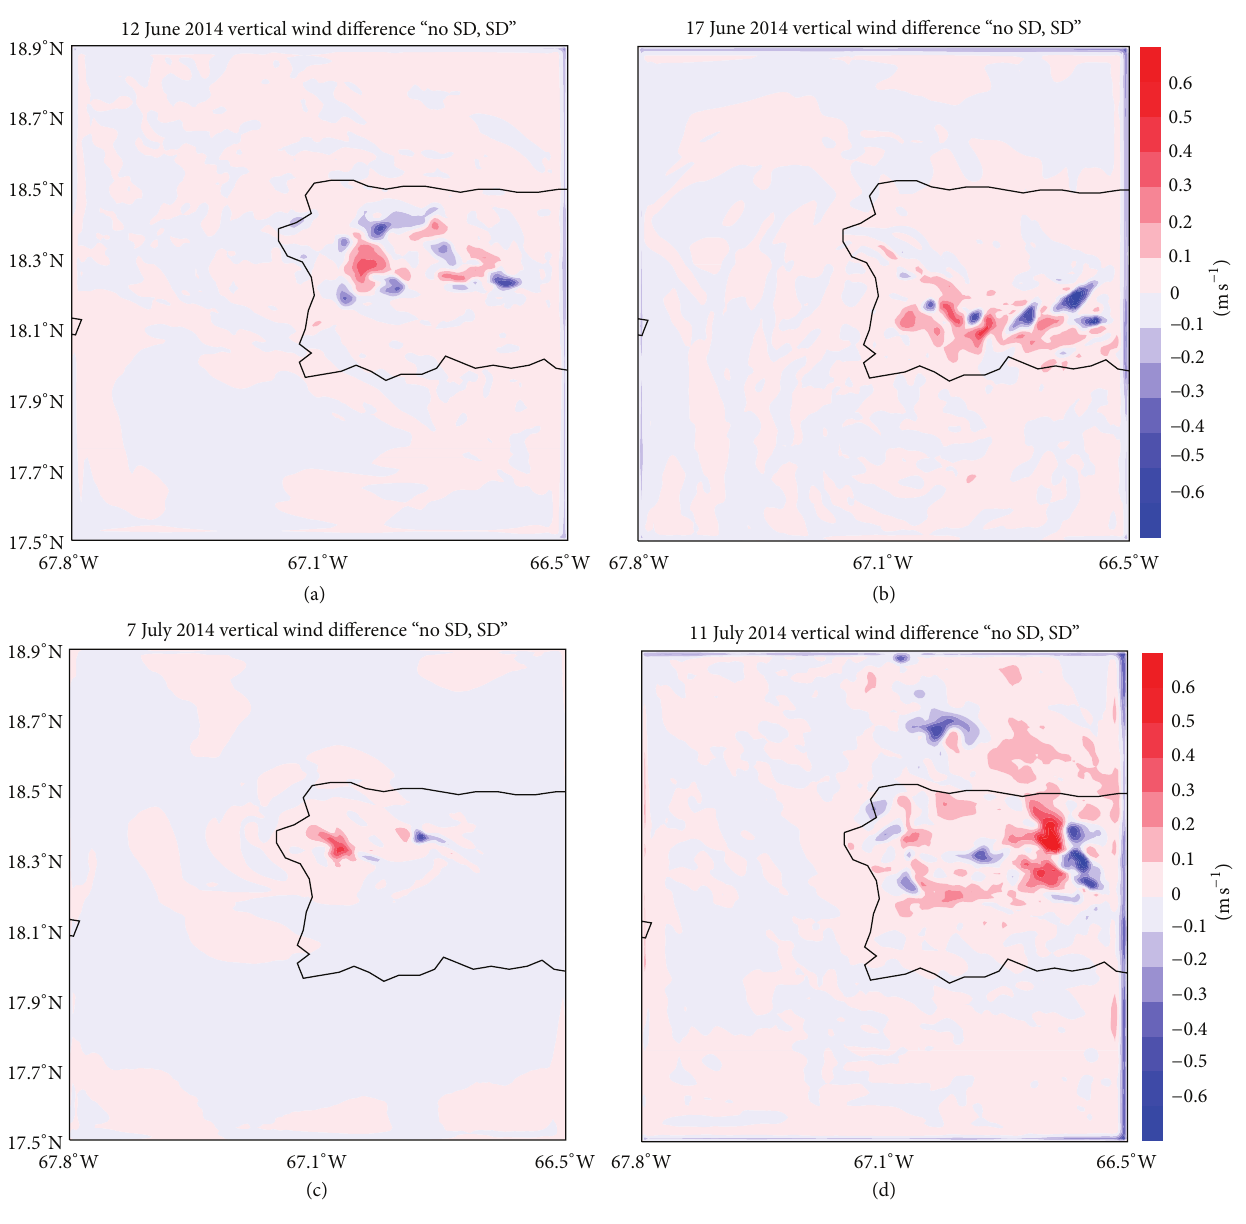
Figure 11: RAMS generated PBL (from the surface to 6000 m) averaged vertical wind differences over the duration of the events for SD and no SD cases for 12 June 2014 (a), 17 June 2014 (b), 7 July 2014 (c), and 11 July 2014